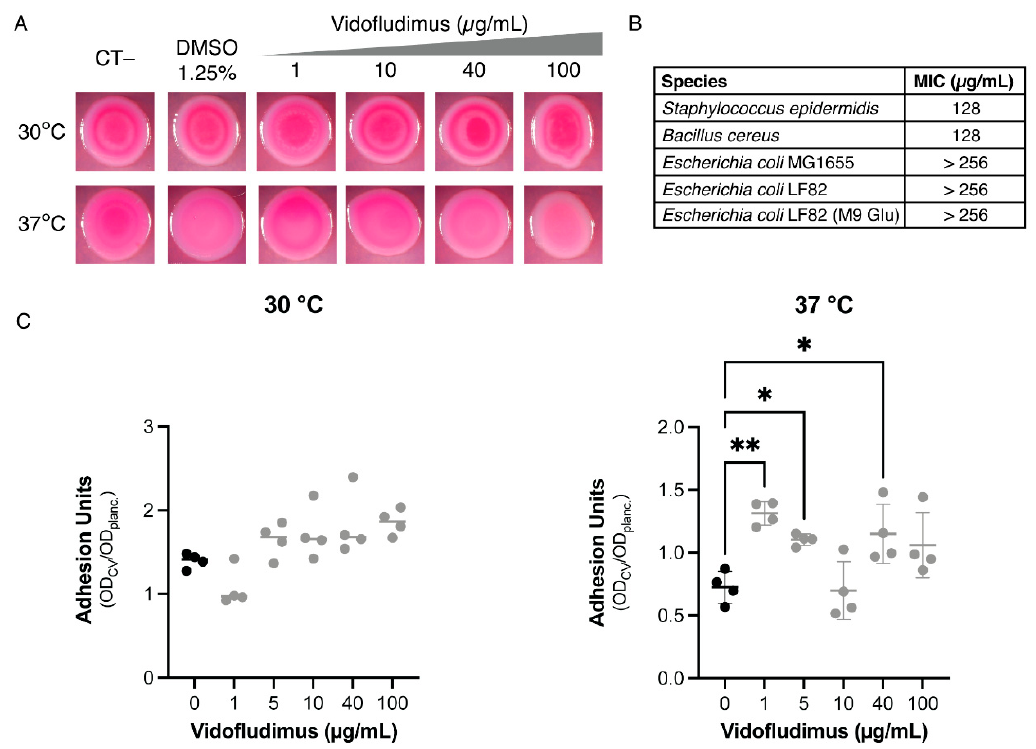
Figure 4. Effects of vidofludimus (VF) on LF82 phenotypes and on microbial growth. ( A ) Phenotypes on Congo red-supplemented YESCA agar medium, either at 30 °C or 37 °C, in the presence of growing VF concentrations. The final DMSO concentration was kept at 1.25% for all VF concentrations tested. ( B ) Minimal inhibitory concentrations (MIC) on E. coli (LF82, in YESCA and M9 Glu 0.2% media, and the laboratory strain MG1655, in YESCA medium) and the Gram positive bacteria Bacillus cereus and Staphylococcus epidermidis (in YESCA medium). ( C ) Biofilm formation, measured as surface adhesion to polystyrene microtiter plates, using the Crystal violet method, in the presence of increasing VF concentrations. Cultures were grown overnight in YESCA medium at either 30 °C or 37 °C. *, p -value < 0.05, **, p -value < 0.01 One-way ANOVA with Tukey’s test for multiple comparisons. Only significant values are shown.